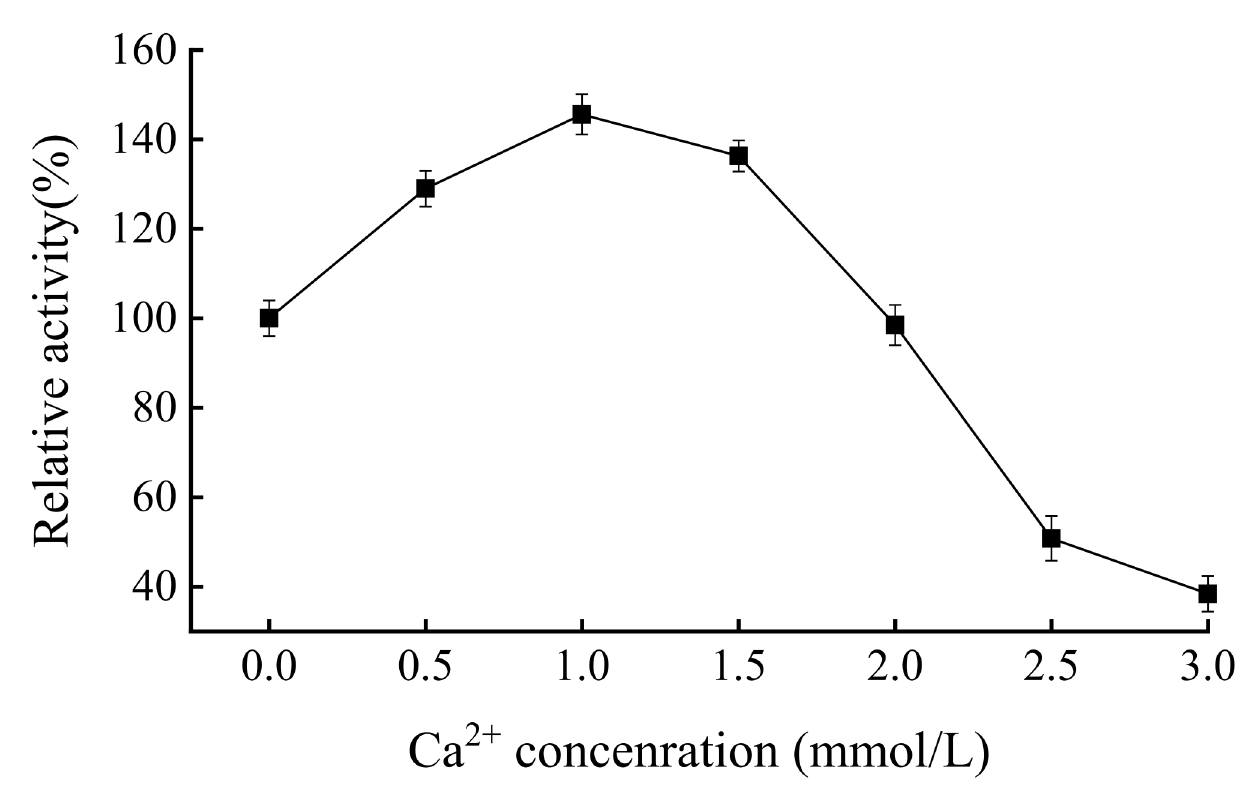
Figure 6. The effect of Ca 2+ concentration on the relative activity of A129V. The pectate lyase activity without Ca 2+ was taken as 100%. Values are the means ± SD of three replicates.